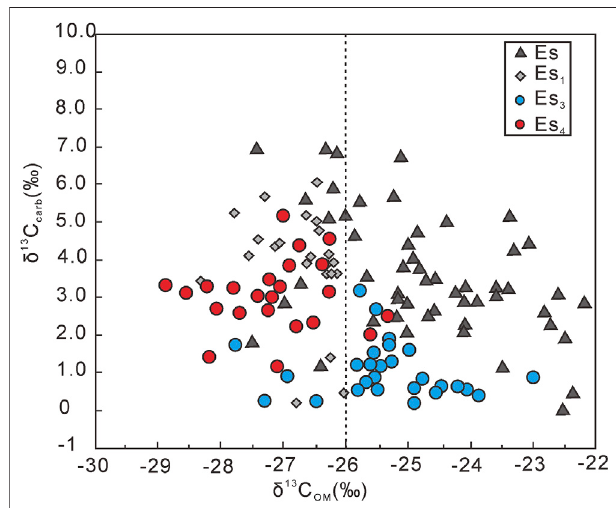
FIGURE 10 | Crossplot δ 13 C om values of vs. δ 13 C Carb values for Es 3 and Es 4 rocksamplesfromtheLanggusag,Jizhongsubbasin.TheEssourcerock samples from the Bozhong sag (Yin et al., 2020) and the Es 1 source rock samples from the Raoyang sag (Yin et al., 2018) were plotted for comparison of the shift of the δ 13 C om values to evaluate the paleoproductivity in the Es 3 and Es 4 rock